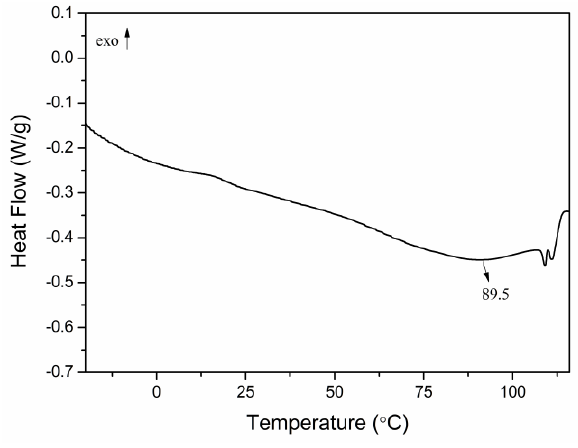
Figure 2. DSC curve of P(ND- co -D) precursor.